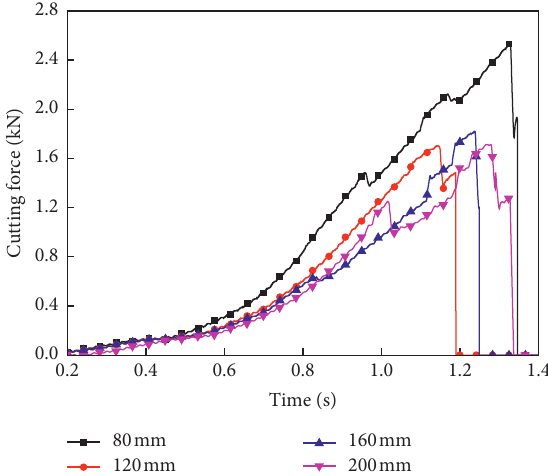
Figure 21: Variation in cutting force with time at different height.